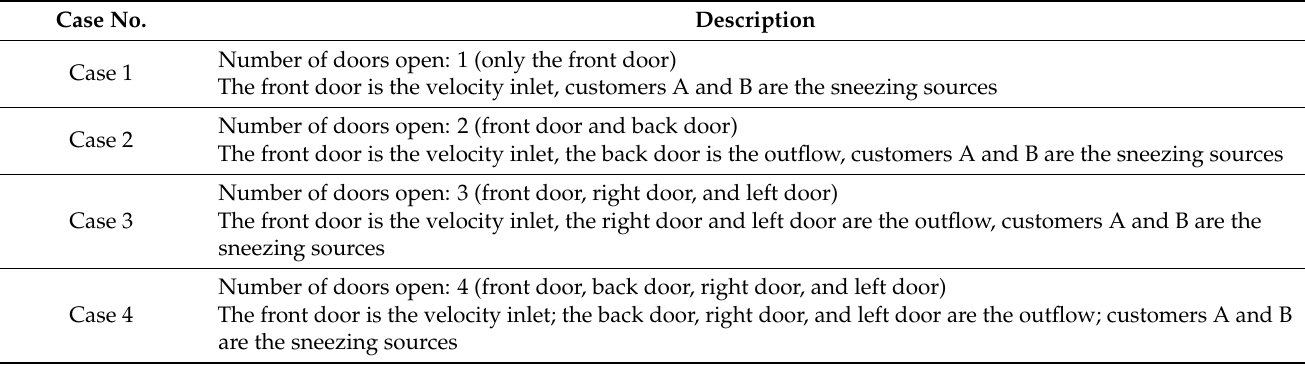
Figure 1. Geometric model of a small farmers’ market. Table 1. Simulation